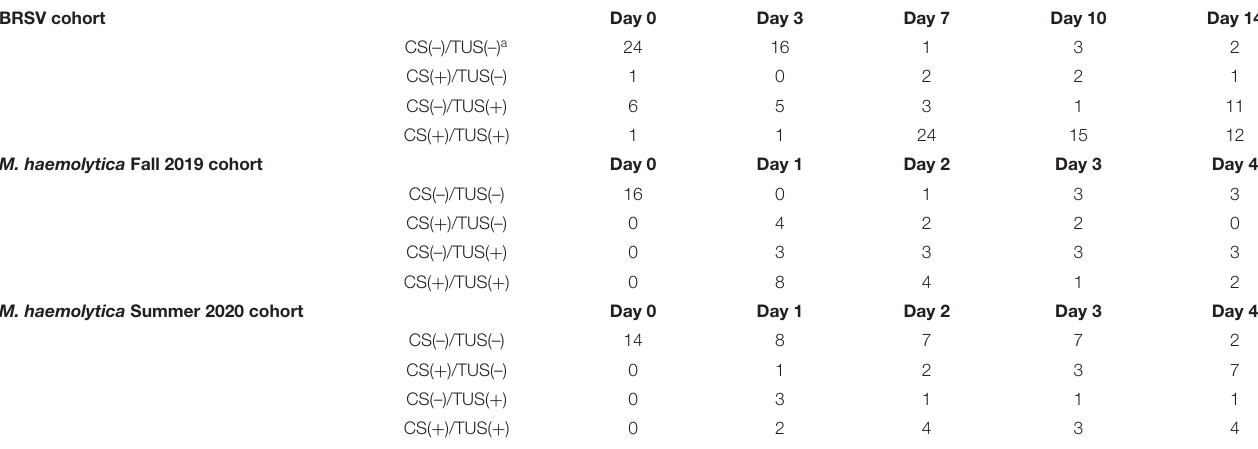
TABLE 2 | TUS and clinical score progression of calves across BRSV and M. haemolytica infection. BRSV cohort